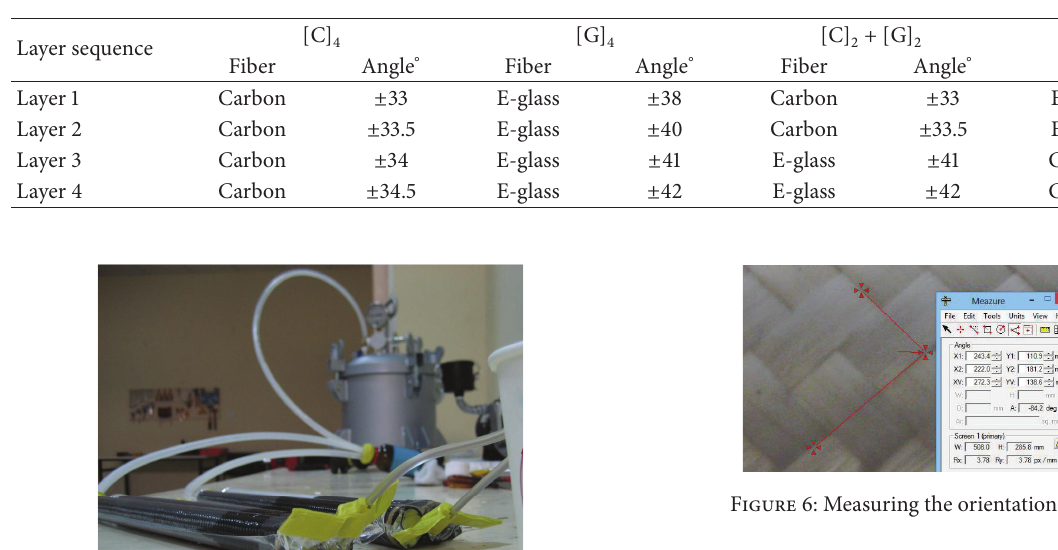
Table 3: Average fiber orientation angles on each layer for each sequence.